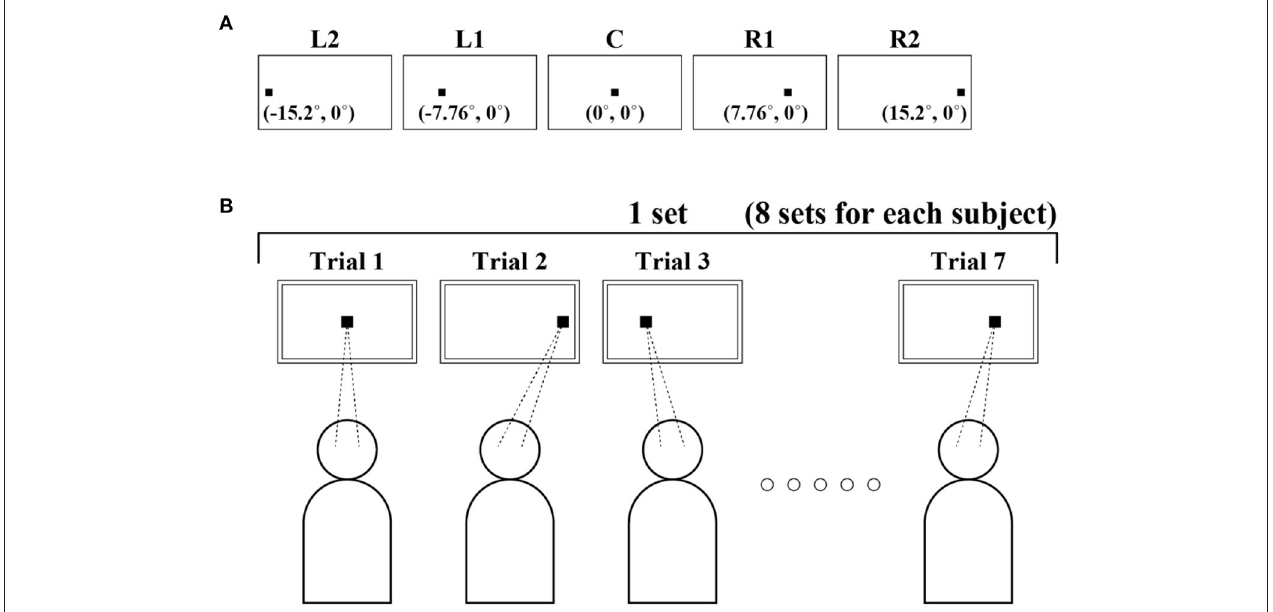
FIGURE 1 | Schematic diagram of the experiment. (A) Five target positions from the left to right, which were referred to as L2, L1, C, R1, and R2, respectively. (B) An experimental protocol. A small target was projected at 0 in the vertical direction and at − 15.2 ◦ , − 7.76 ◦ , 0 ◦ , 7.76 ◦ , and 15.2 ◦ in the horizontal direction. Fixational eye movement (FEM) was measured to obtain gaze (GZ) time series for each of these five positions of the fixation target. Single trials lasted 35s, which were interrupted by several eye blinks. The target position for each trial was chosen pseudo-randomly from the five locations. Each subject performed 56 trials in